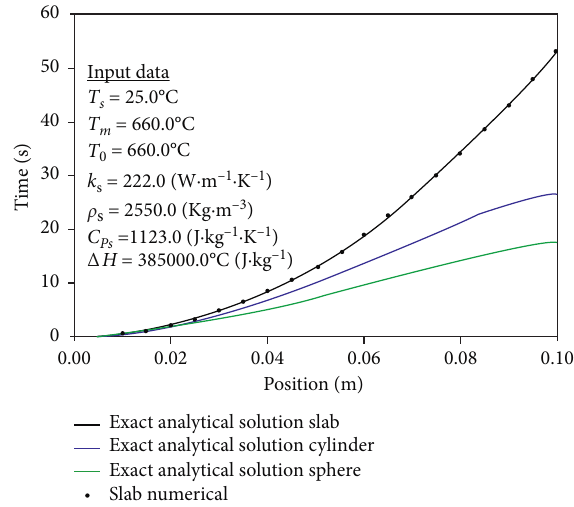
Figure 6: Comparison between numerical and analytical solutions for diffusion times as a function of one-dimensional correlation ( V / A ) for a slab, a cylinder, and a sphere. 0